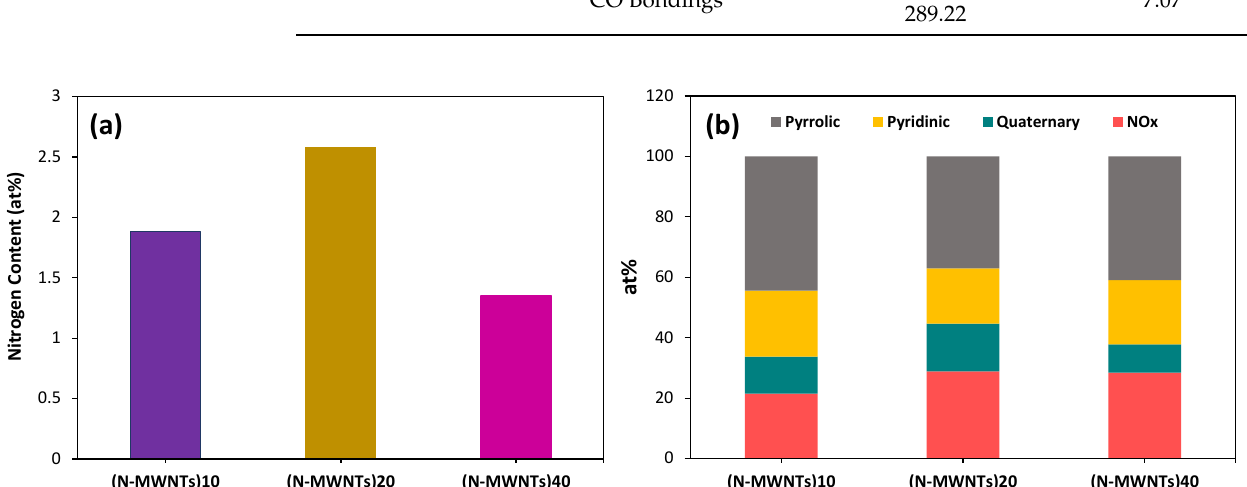
Figure 2. XPS Spectra and C1s and N1s of N-doped CNTs synthesized using different ratios of catalyst.